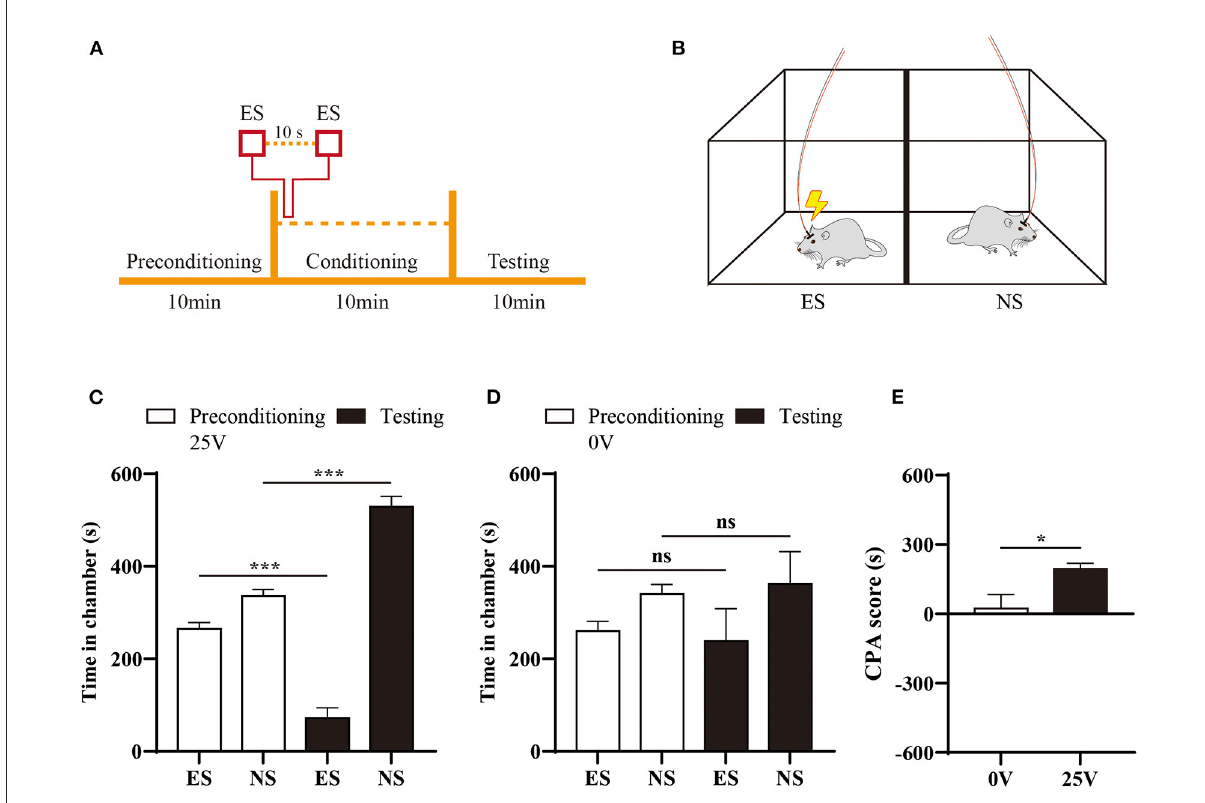
FIGURE4 Aversive response to electrical stimulation of ION territory . (A) Schematic of CPA paradigm. (B) Rats received electrical stimulation (ES) in one chamber during conditioning phase of CPA, and none stimuli (NS) was paired with the other chamber. (C) Comparison of time spent in the chamber pre- and post-stimuli treatment. N = 6; *** p < 0.001, paired Student’s t -test. (D) Sham stimuli did not induce preference to either chamber in the CPA testing. (E) Naïve rats developed aversion to 25V electrical stimuli of ION territory, demonstrated by an elevated CPA scores with sham stimuli treatment. N = 6; * p < 0.05, unpaired Student’s t